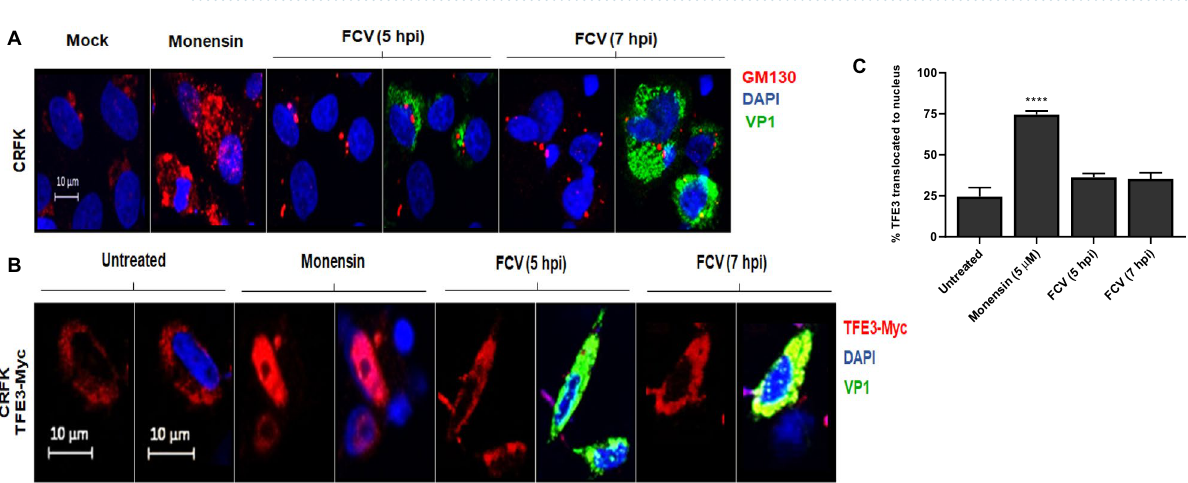
Figure 4. CRFK cells infected with FCV showed no evidence of Golgi stress or activation of the TFE3 pathway. ( A ) CRFK cells were infected with FCV and fixed at 5 and 7 hpi. The cells were probed against capsid protein VP1 (green), and GM130 (cis-Golgi, red). Nuclei were counter stained with DAPI (blue). ( B ) CRFK cells were transfected with 1 µg of plasmid DNA of transcriptional factor TFE3 (pTEF3-Myc), then infected with FCV at MOI = 5 and fixed at 5 and 7 hpi. Cells were probed against capsid protein VP1 (green), Myc (TFE3, red). Nuclei were counter stained with DAPI (blue). Cells were analyzed using a Zeiss LSM 700 confocal microscope with laser sections: 0.45 μm. ( C ) Percentage of TFE3 translocated from the cytoplasm to nucleus were measured through images analysis with Zen Blue edition 2.6 software and the results were plotted using GraphPAD Prism version 8.01. *p ≤